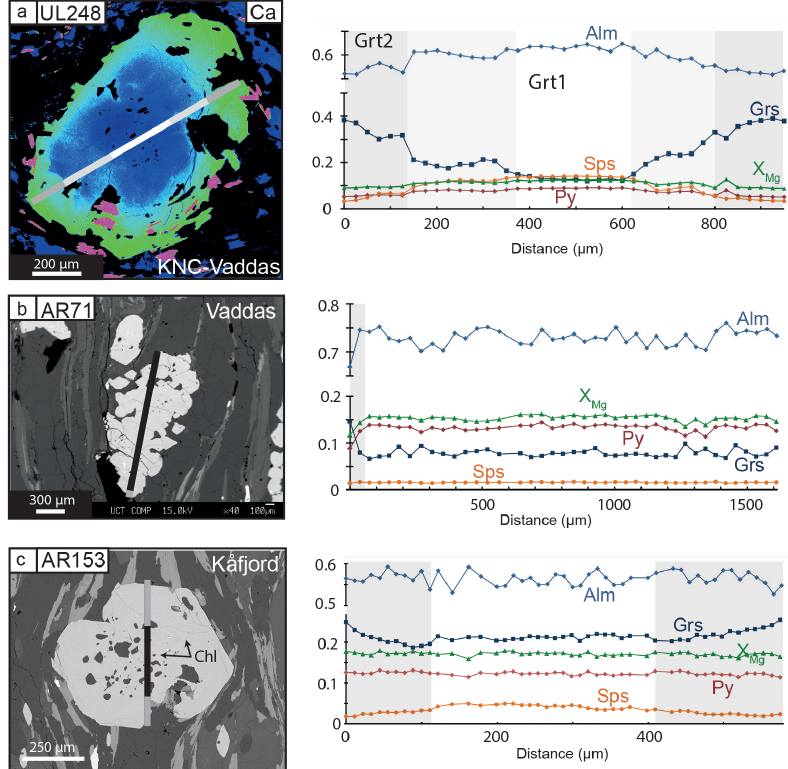
Figure 6. Backscattered electron (BSE) images, compositional maps, and garnet profiles from the Vaddas and Kåfjord nappes. (a) Garnet from the KNC–Vaddas boundary, sample UL248, displays strong zoning with defined core (Grt1) and rim (Grt2) zones and a transition zone between them. Pink grains in garnet rims are titanite. (b) Garnet from the Vaddas Nappe, sample AR71, has a flat profile with occasional thin growth rims. (c) Garnet from the Kåfjord Nappe, sample AR153, has a profile that shows some zoning, with mainly Grs and Sps contents displaying a difference between inclusion-rich cores and inclusion-poor